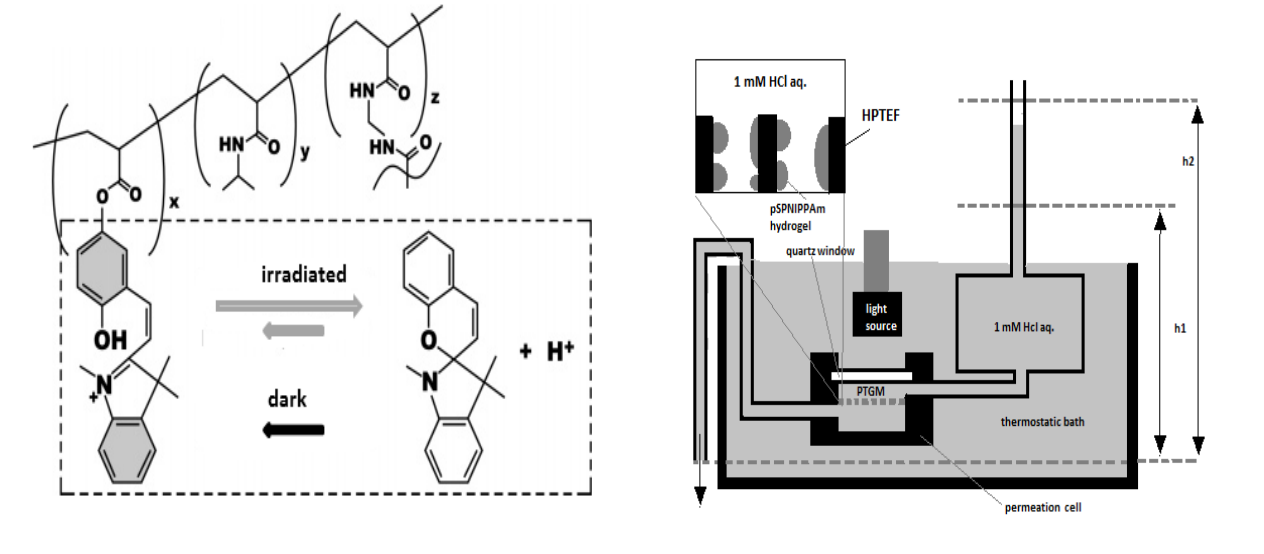
Figure 9. Light-controllable devices for